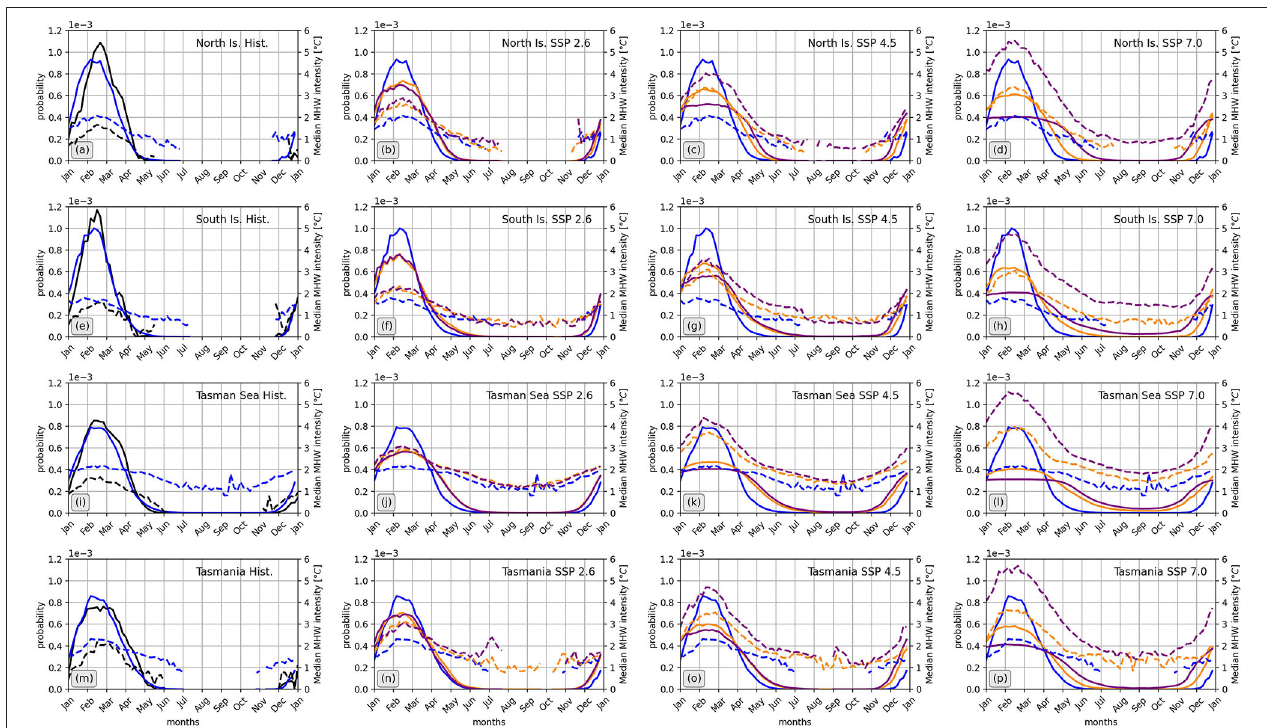
FIGURE 6 | Seasonality of MHW probability (solid lines, left y -axis), measured by the number of grid boxes which experience a MHW, and median MHW intensity (dashed lines, right y -axis) for selected regions. (a–d) coastal region around the North Island. (e–h) coastal region around the South Island. (i–l) over the Tasman Sea and (m–p) around Tasmania. Regions are shown in Figures 1 , 2 and Supplementary Figure S4 . NOAA OI-SST and NZESM for the historical period from 1995–2014 is represented in black and blue, respectively. The orange and purple lines show results for the period 2040–2059 and 2080–2099, respectively. The time bins are 5 days wide and the area under curve for the probability integrates to 1. The model data represents results of a 60 year member ensemble i.e., 20 years of data from each of the three-ensemble